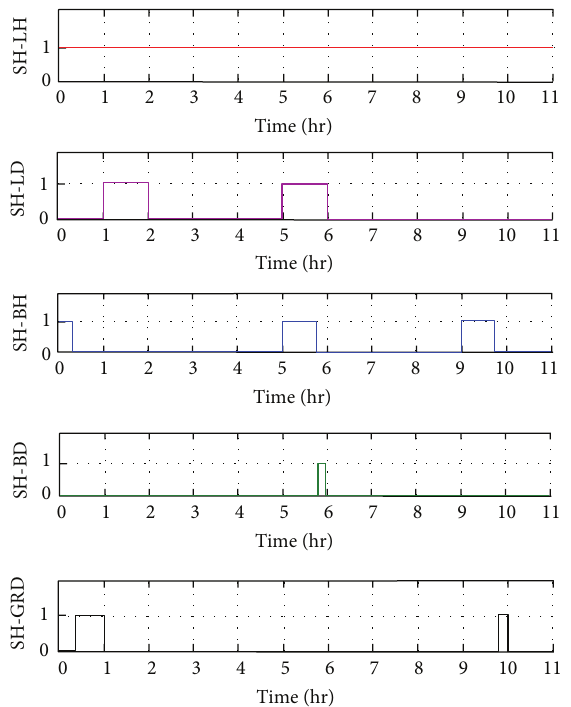
Figure 11: Switching operations of solar hostel agent (SHA).